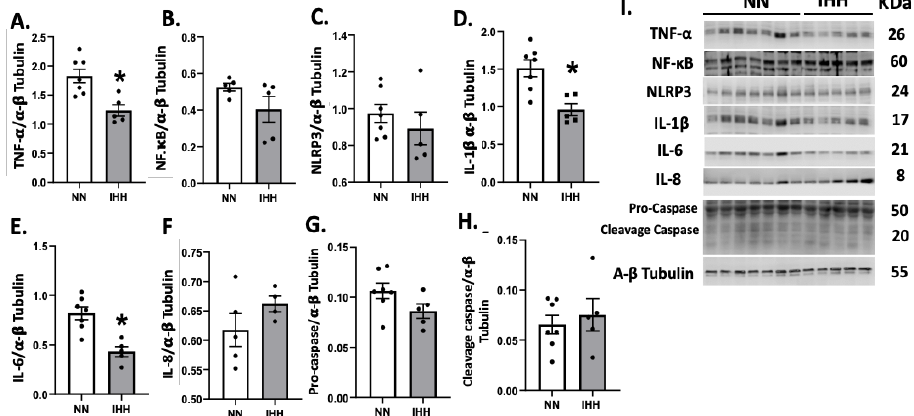
Figure 4. Cardiac levels of inflammatory-related proteins. Cardiac levels of TNF- α ( A ), NF-KappaB p65 subunit ( B ), NLRP3 ( C ), IL-1 β ( D ), IL-6 ( E ), IL-8 ( F ), Procaspase-1 ( G ), and cleaved-caspase 1 ( H ). ( I ), corresponds to blot bands and standard weight. Groups are normobaric normoxia (NN, n = 6) and intermittent hypobaric hypoxia (IHH, n = 6). Data are expressed in mean ± SEM. Significant differences ( p ≤ 0.05): * vs. NN.